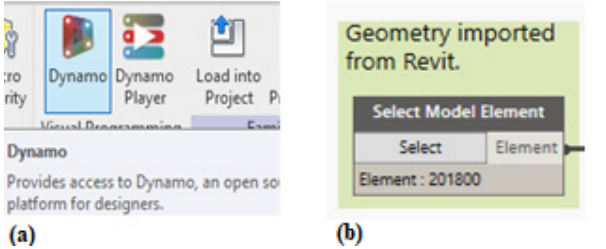
Figure A2. ( a ) Plugin Dynamo in Revit TM . ( b ) Importation node for the construction element.